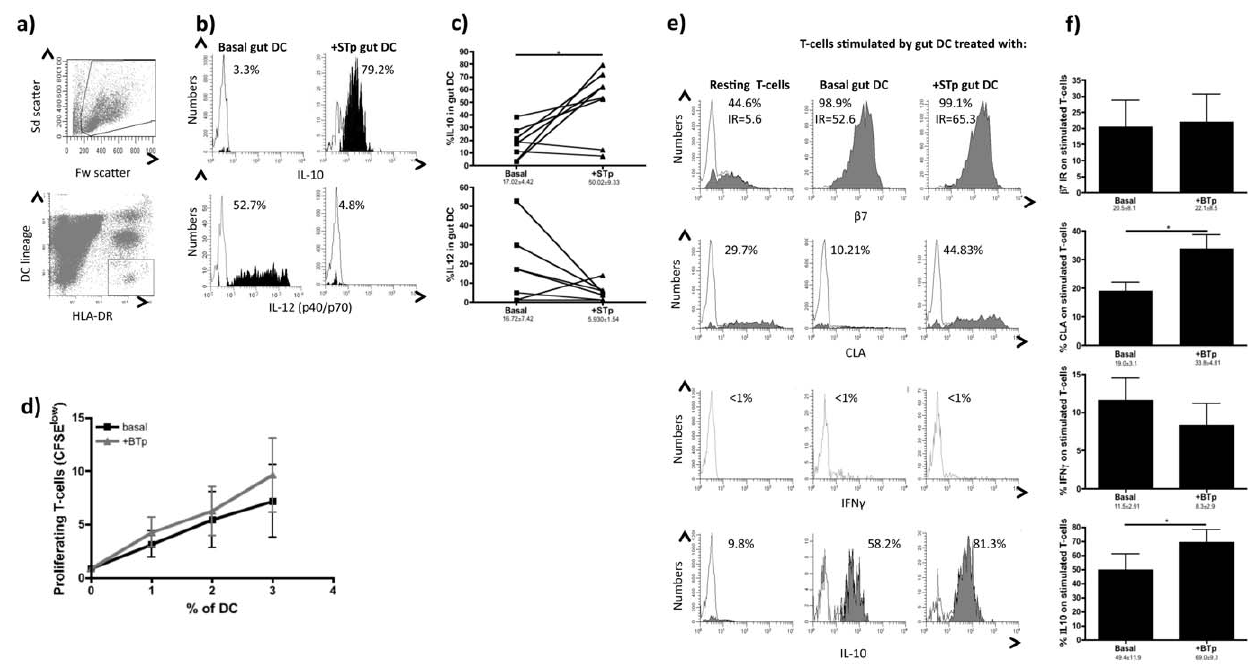
Figure 3. STp primes human intestinal DC towards a regulatory phenotype. a ) DC were identified in total colonic lamina propria mononuclear cells from healthy controls by flow cytometry according to the Forward and Side scatters and the subsequent HLA-DR/lineage cocktail dot plot. DC were defined as HLA-DR + and lineage – (CD3, CD14, CD16, CD19 and CD34). b ) Ongoing intracellular IL-10 and IL-12(p40/p70) cytokine production (closed histograms) was determined in colonic DC cultured with and without STp (10 m g/ml). Pooled data of 8 independent experiments are shown in panel c ). d ) Stimulatory capacity of such intestinal DC was determined upon 5 days culture in the presence of allogeneic CFSE-labelled T-cells as stated in Figure 2c. Results show the mean 6 SEM of 8 independent experiments. e ) Imprinted homing profile (gut-homing: b 7; skin-homing: CLA) and intracellular cytokine content (IL-10 and IFN c ) of stimulated T-cells (CFSE low ) was compared to resting T-cells cultured in the absence of intestinal DC. Pooled data of eight independent experiments is shown in panel f ). Closed histograms represent the percentage of positive cells after subtraction from respective isotypes. Lines and bars represent mean 6 SEM.